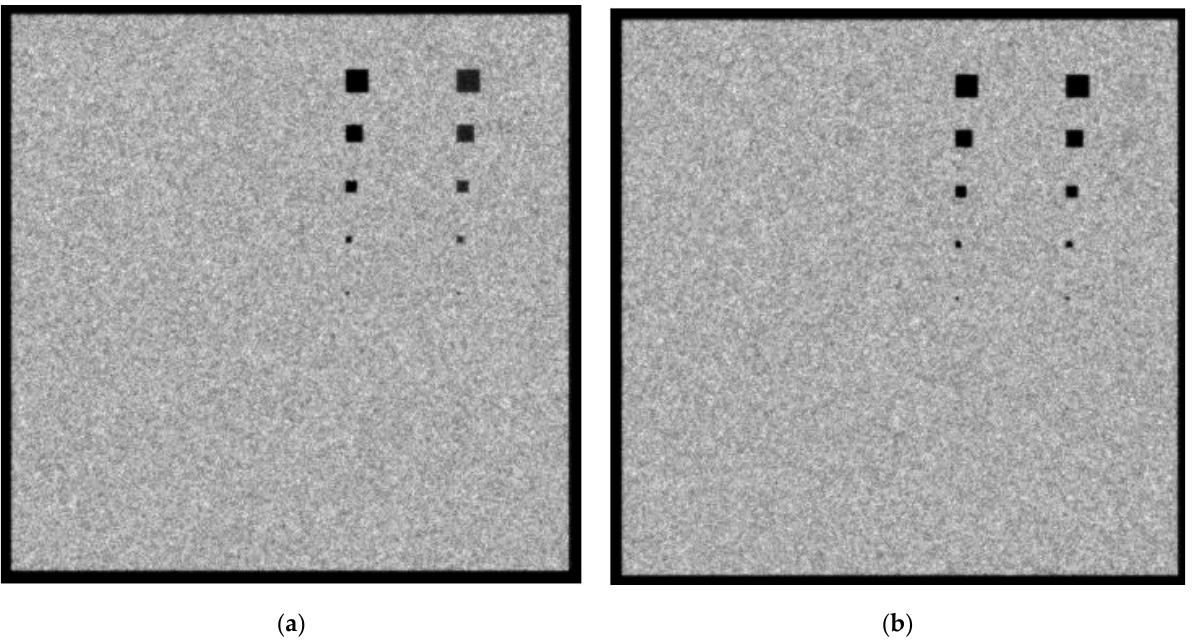
Figure 9. A 6 cm phantom image for Mo/Mo 5 mGy and 28 kVp spectrum with ( a ) 0.1 cm lesion thickness and ( b ) 0.5 cm lesion thickness.